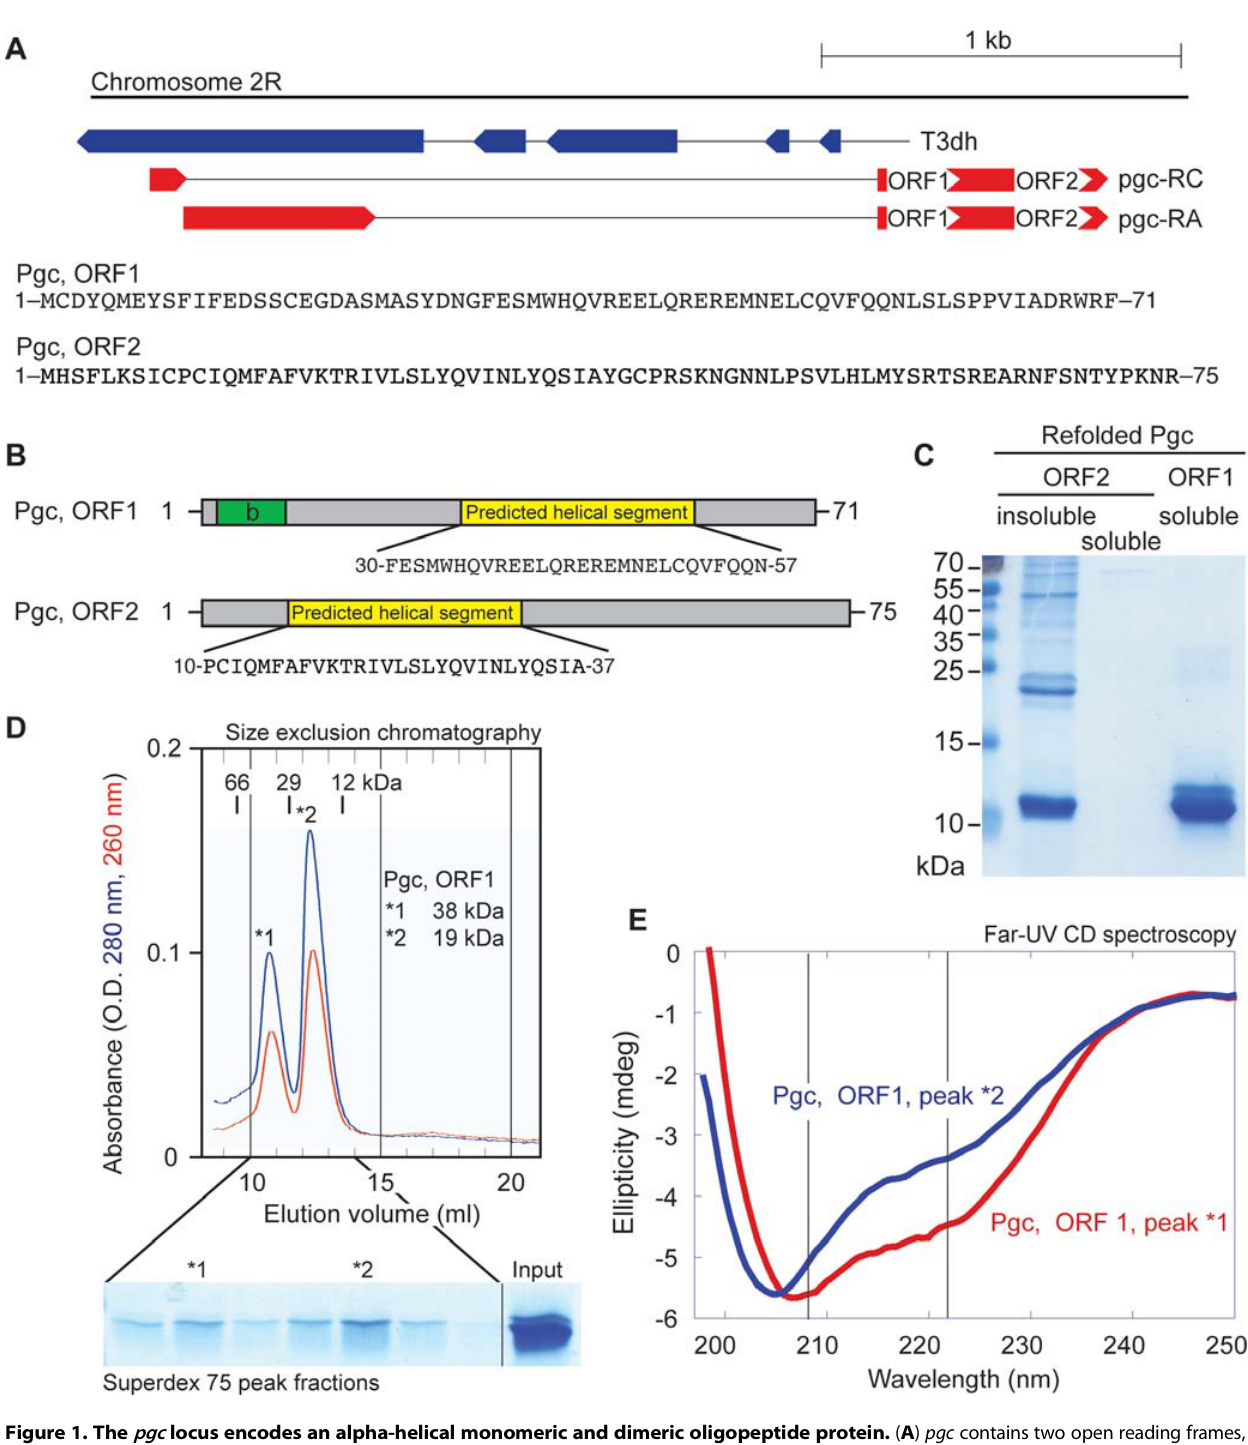
Figure 1. The pgc locus encodes an alpha-helical monomeric and dimeric oligopeptide protein. ( A ) pgc contains two open reading frames, encoding potential 71 and 75 residue oligopeptide proteins (Pgc ORF1 and ORF2, respectively). ( B ) The two candidate oligopeptides are predicted to contain alpha-helical secondary structure. ( C ) E. coli expressed and purified Pgc ORF1 is a soluble protein, in contrast to ORF2, which fails to refold in vitro . ( D ) Size-exclusion chromatography of PGC ORF1 reveals two chromatographic species, one migrating at 18 kDa, the other at 36 kDa, consistent with monomer and dimer fractions of (His) 6 -tagged Pgc ORF1. Absorbance signal at 280 nm (blue) and 260 nm (red). ( E ) Far-UV circular dichroism spectroscopy spectrum of purified, recombinant PGC ORF1 reveals that recombinant Pgc ORF1 protein contains intrinsic alpha-helical structure. Peak *1 (red), corresponding to the dimeric Pgc ORF1 complex, contains a higher alpha-helical content than monomeric Pgc1 (peak *2, blue). doi:10.1371/journal.pone.0002506.g001 does not change the Ser2 phosphorylation state of Pol II. The loss In order to directly test whether Pgc protein, rather than its RNA of CTD Ser2 phosphorylation suggests Pgc ORF1 directly or message, is responsible for the decrease in CTD Ser2 phosphory- indirectly functions by repressing normal Pol II function. lation in vivo , we micro-injected the anterior pole of stage 3–4